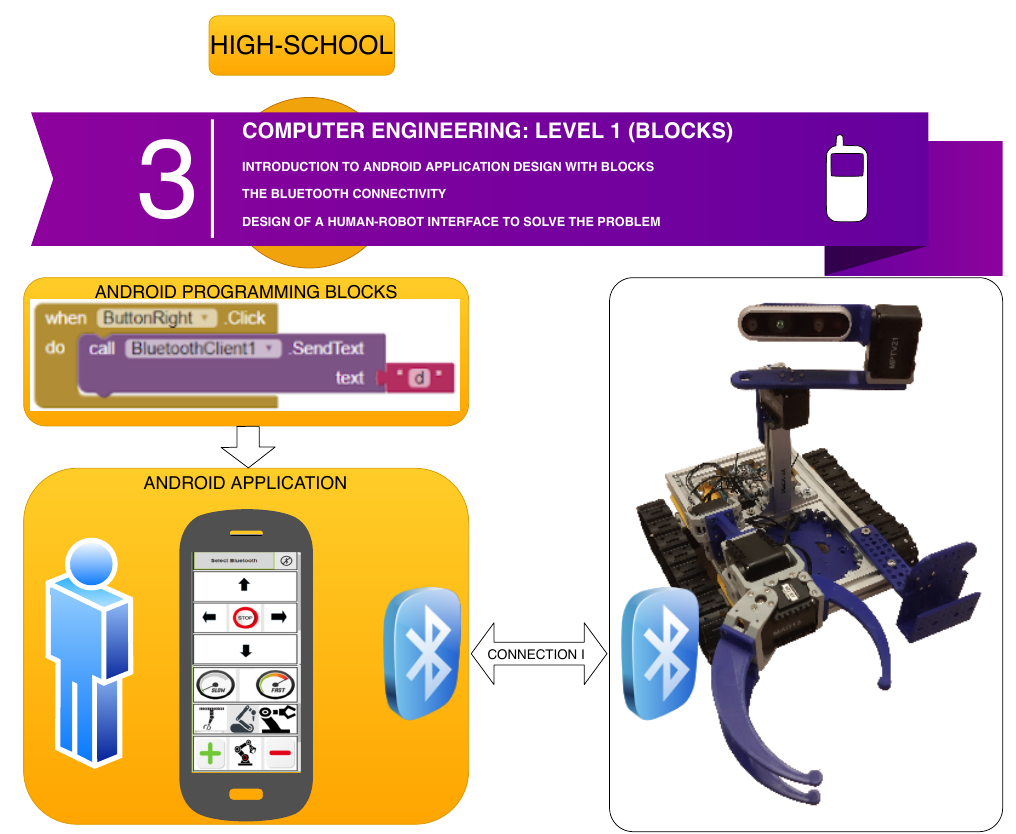
Figure 13. Software architecture for the Computer Engineering Level 1 exercise.